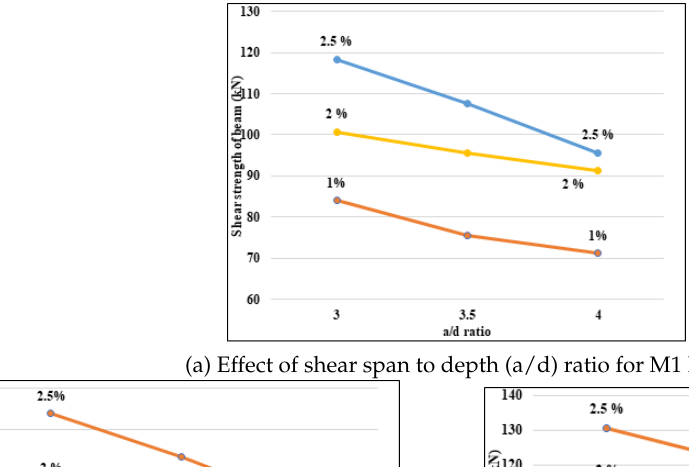
Fig. 3. Effect of longitudinal steel ratio